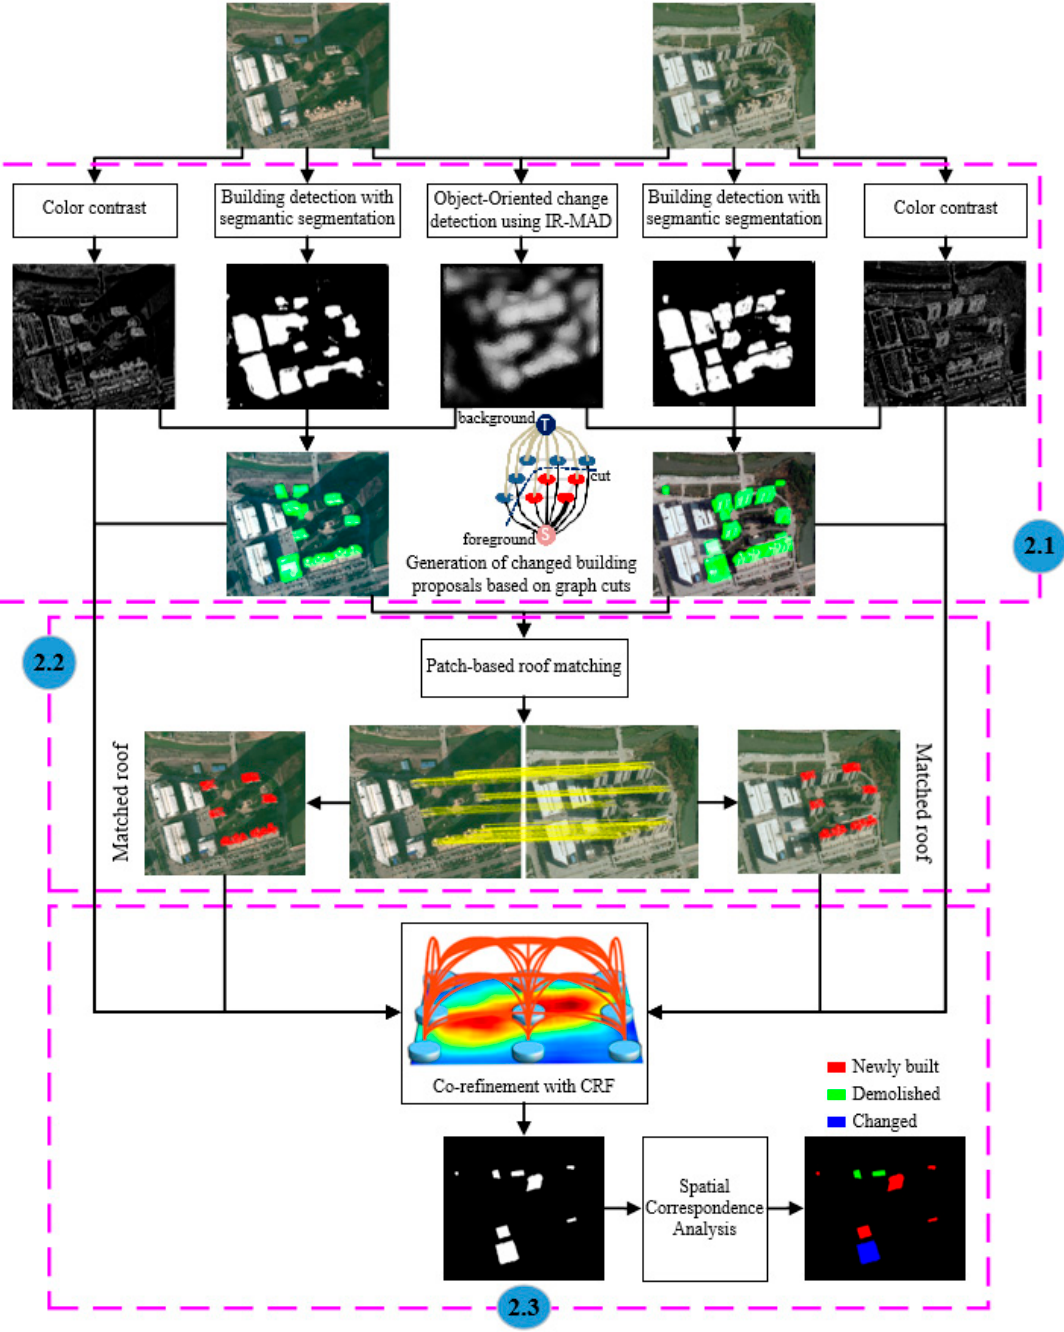
Figure 2. Flowchart of the proposed patch-based matching for the building change detection method.